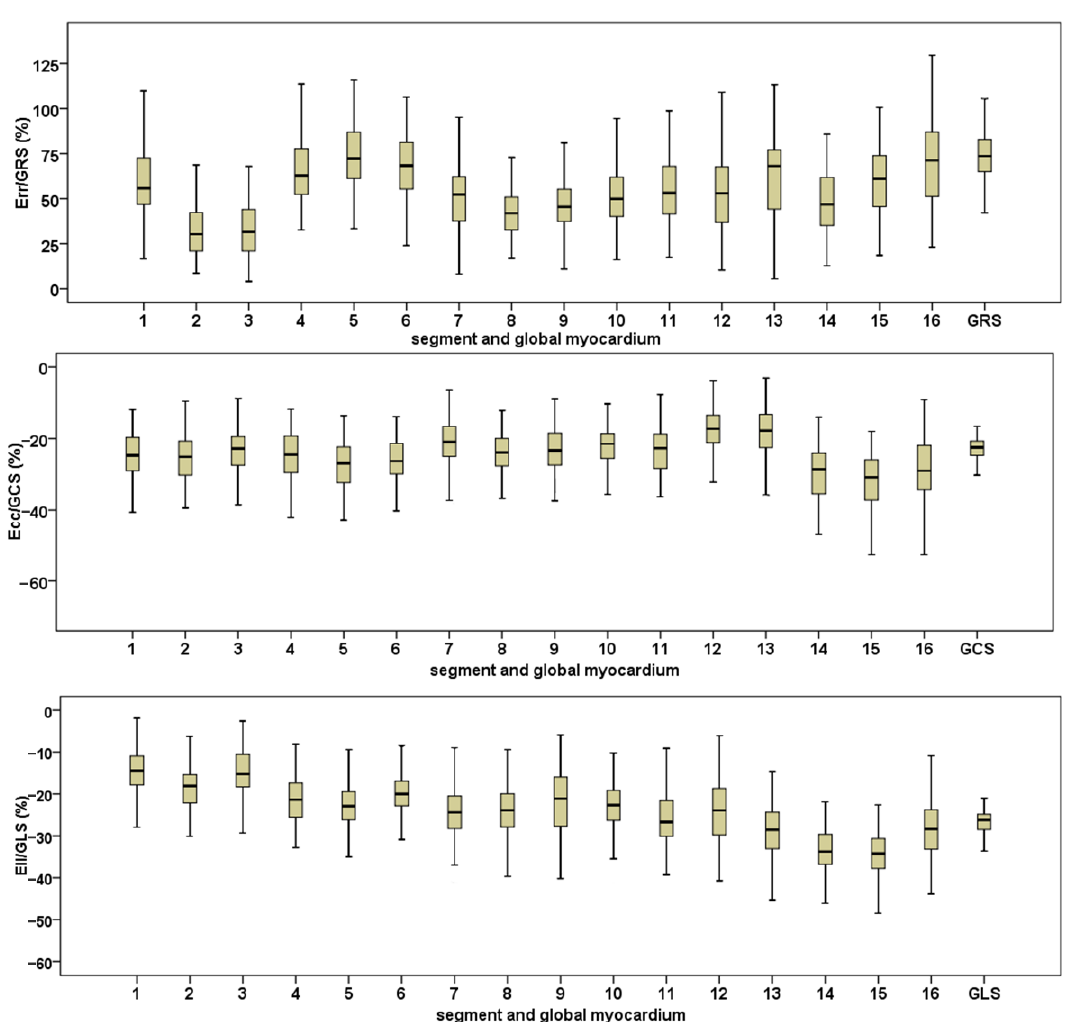
Figure 3. The boxplots for the global and segment myocardial strain value. The top is the image of about 16 segments and the global radial strain. The middle is the image of about 16 segments and the global circumferential strain. The bottom is the image of about 16 segments and the global longitudinal strain. The center box of the boxplots indicates the values from the lower quartile to the higher quartile. The center line shows the median. The range of whiskers is from the minimum to the maximum value. GRS: global radial strain; GCS: global circumferential strain; GLS: global lon- gitudinal strain. Err: radial strain; Ecc: circumferential strain; Ell: longitudinal strain. Table 2. Myocardial strain in different parts of the left ventricle. The Basal The